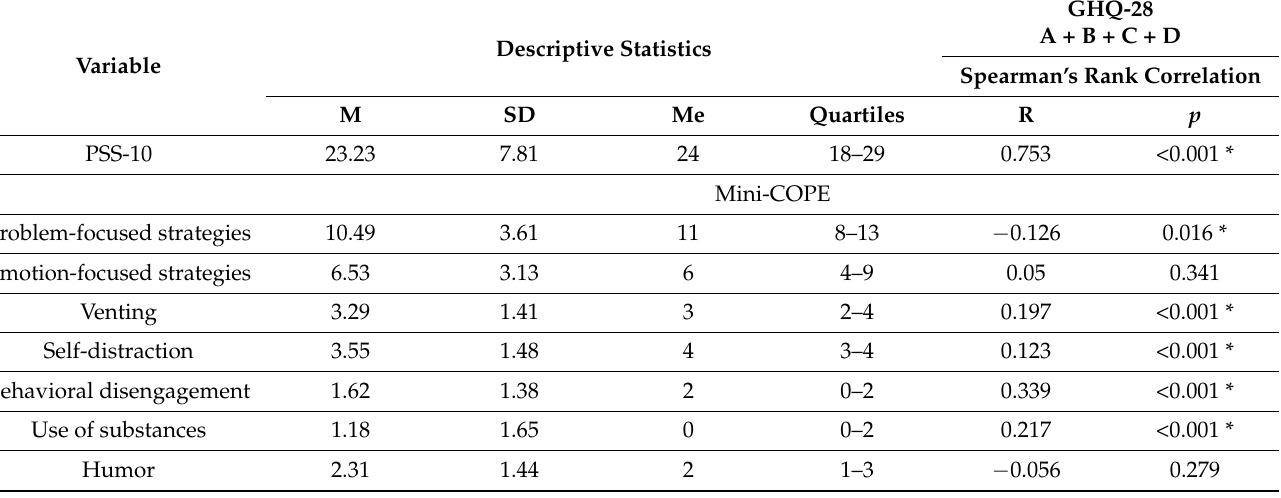
Table 4. The level of perceived stress, the coping strategies used and their impact on the mental health worsening of the subjects (phase II of the